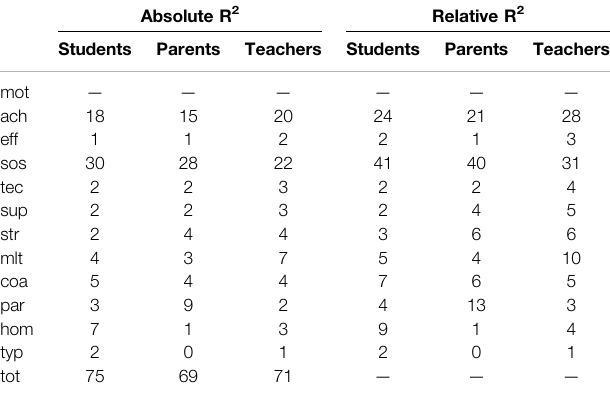
TABLE 10 | Relative weight analysis for student